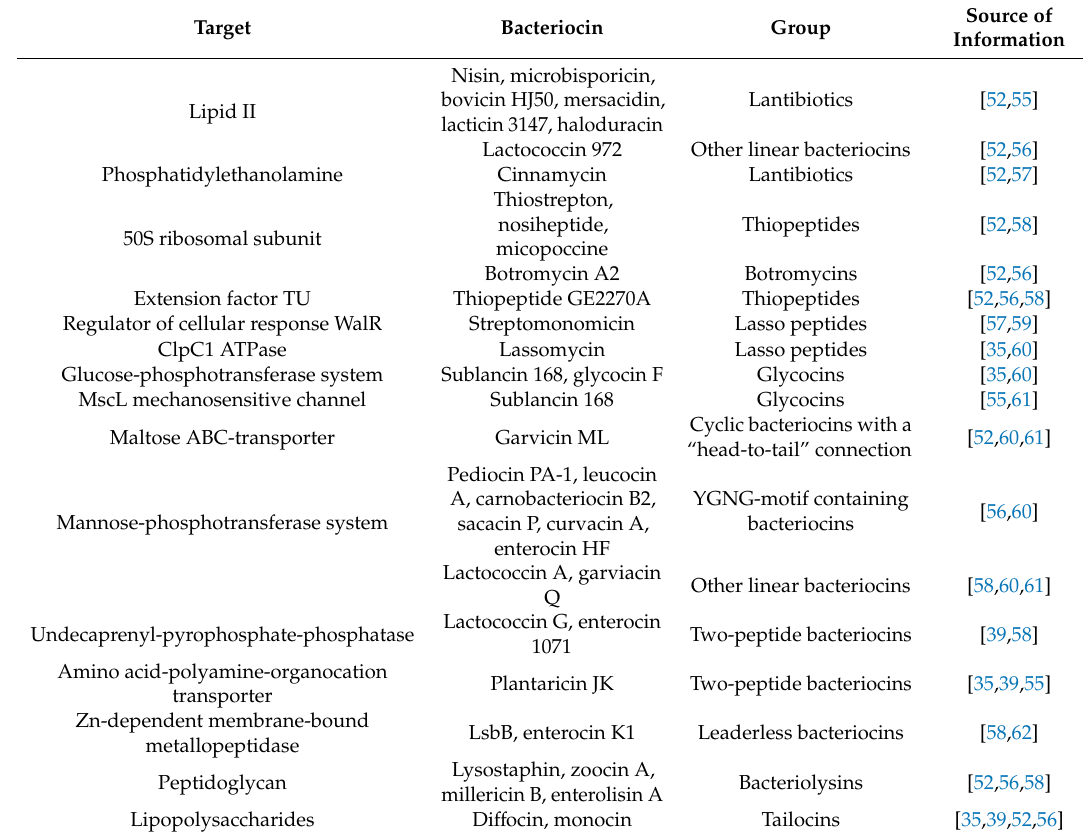
Table 3. Targets and receptors of bacteriocins of Gram-positive